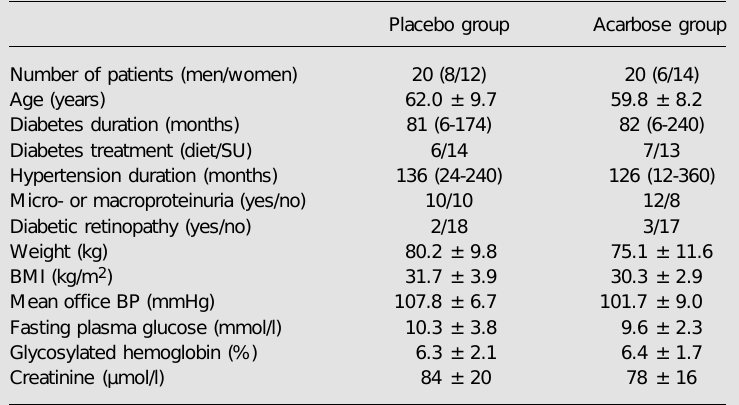
Table 1. Baseline characteristics of the groups of